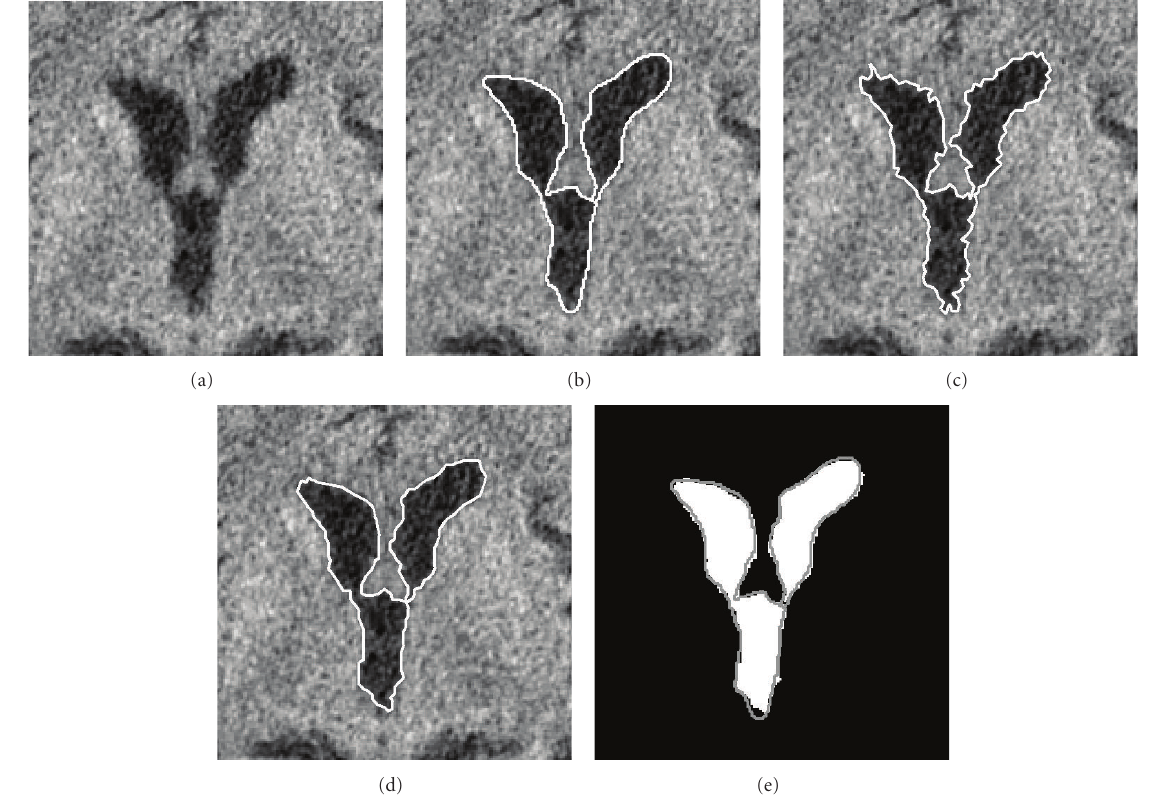
Figure 3: Ventricle extraction: (a) original ventricles in CT, (b) the contour of the GT marked, (c) the result of the thresholding, (d) result of smoothing using snake, and (e) the contour (grey line) of ventricle received by algorithm overlapped over the GT (white